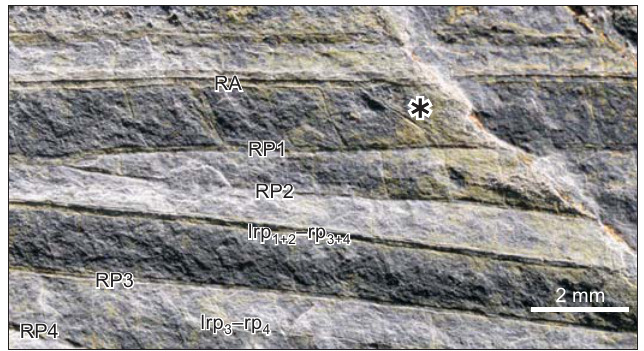
Fig. 3. Triadotypid insect Reisia rieki sp. nov. from Carnian (Triassic) of Kapokkraal locality, Molteno Formation, Karoo Basin, South Africa, PRE/ F/17569a, detail of the oblique crossvein between RA and RP1 (opposite the first fork of RP4, indicated by an asterisk), as indicated on Fig. 2A (light-mirrored, flipped hori